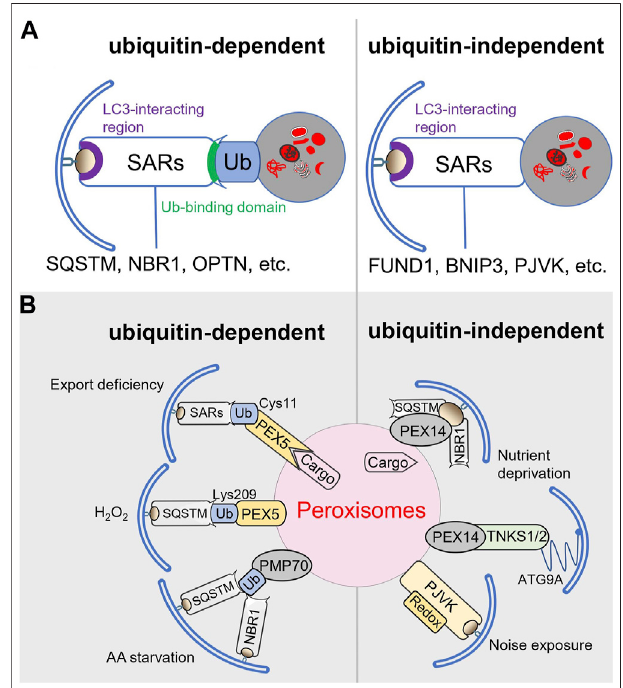
FIGURE 2 | Selective autophagy pathways and pexophagy receptors. (A) Types of selective autophagy. (B) Cargo receptors involved in selective